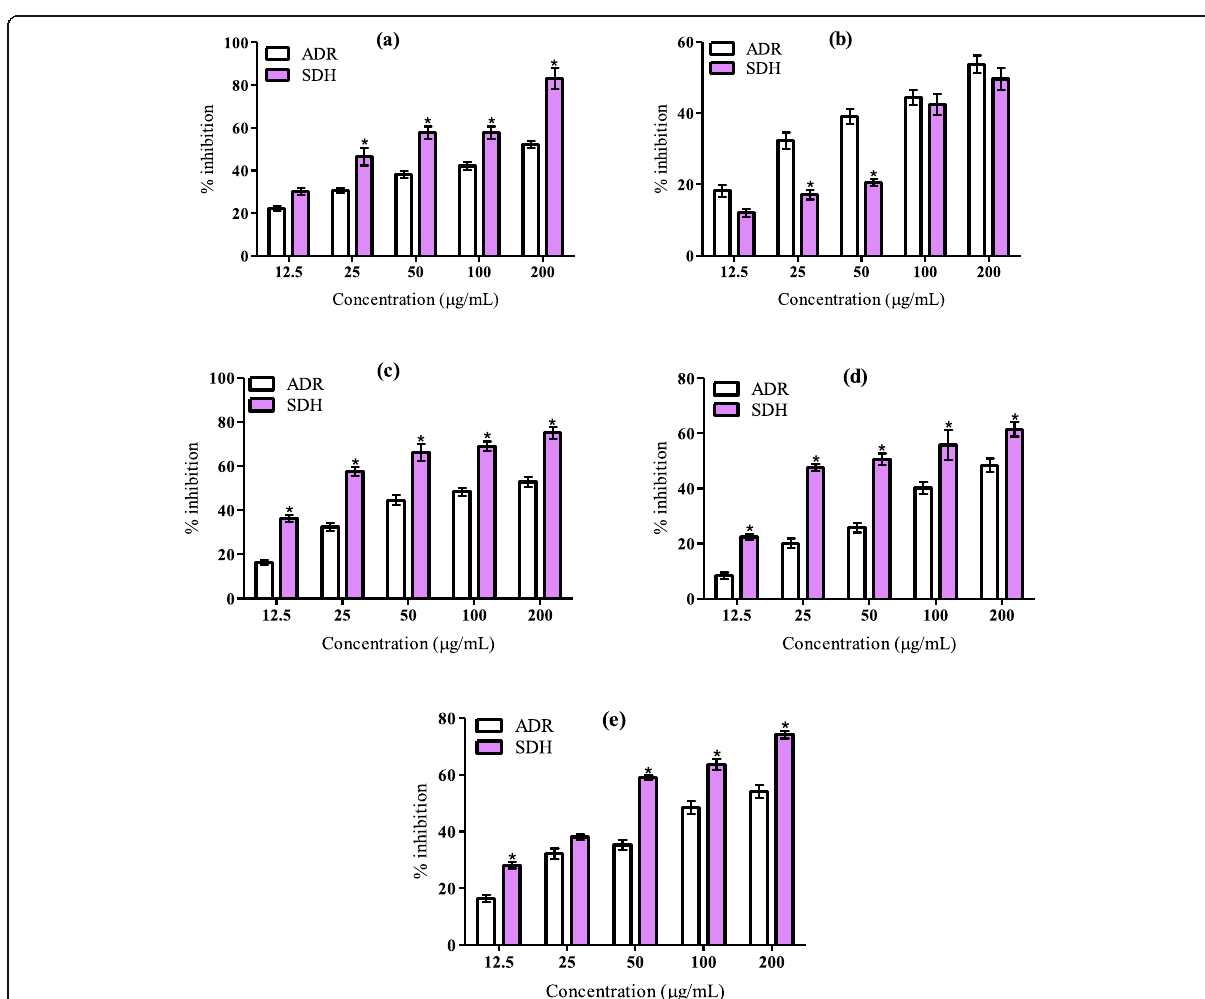
Fig. 1 Inhibitory effect of a apple ( Malus domestica ), b banana ( Musa paradisiaca ), c pawpaw ( Carica papaya ), d watermelon ( Citrullus lanatus ) extract, and e quercetin on the activities of aldose reductase and sorbitol dehydrogenase. ADR, aldose reductase; SDH, sorbitol dehydrogenase. Asterisk indicates values are significantly different at p ˂ 0.05